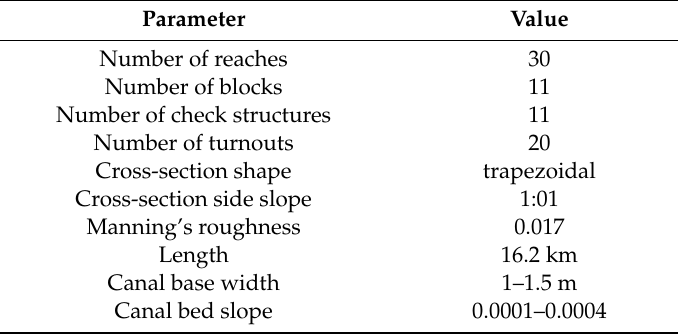
Table 1. Specifications of the East Aghili Canal.